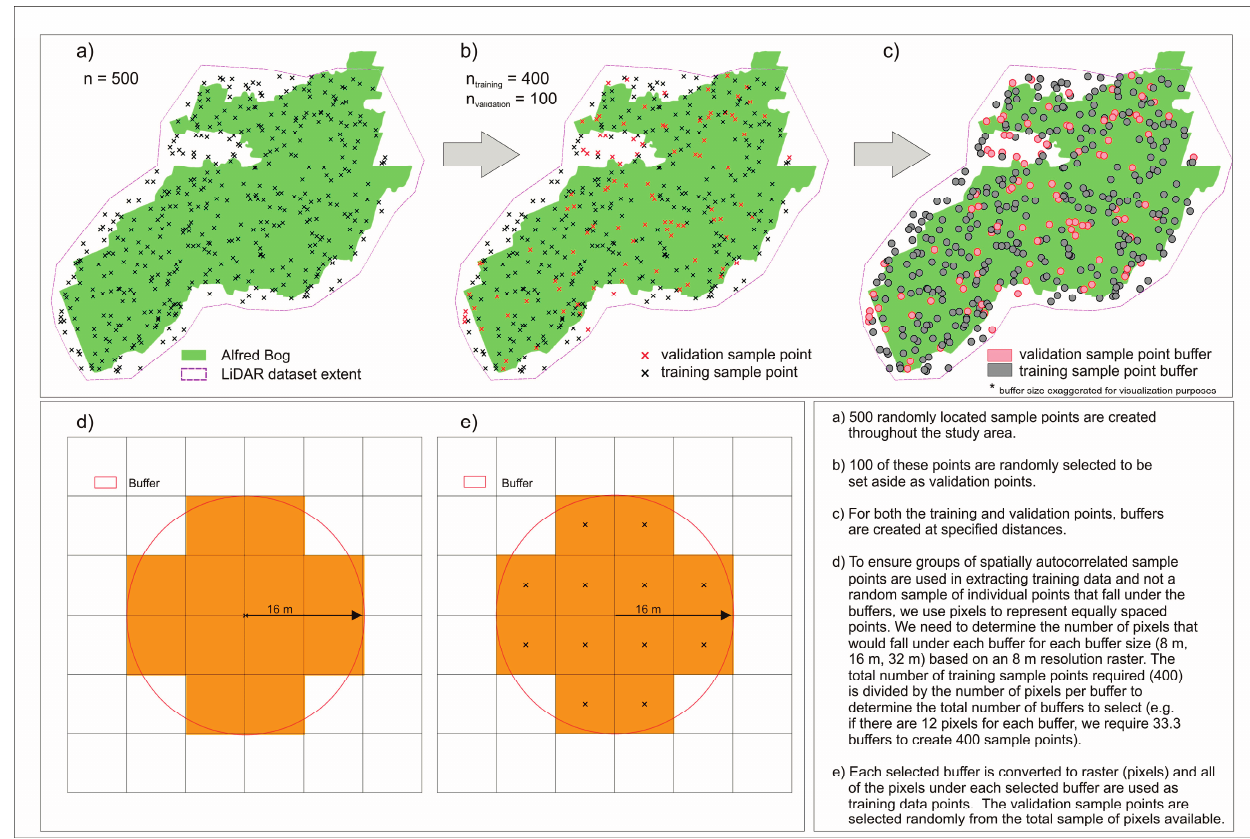
Figure 4. Flow chart describing the methods used to create each sample of data with simulated spatial autocorrelation. ( a ) Five hundred randomly located sample points were created. ( b ) One hundred of these points were randomly set aside as validation